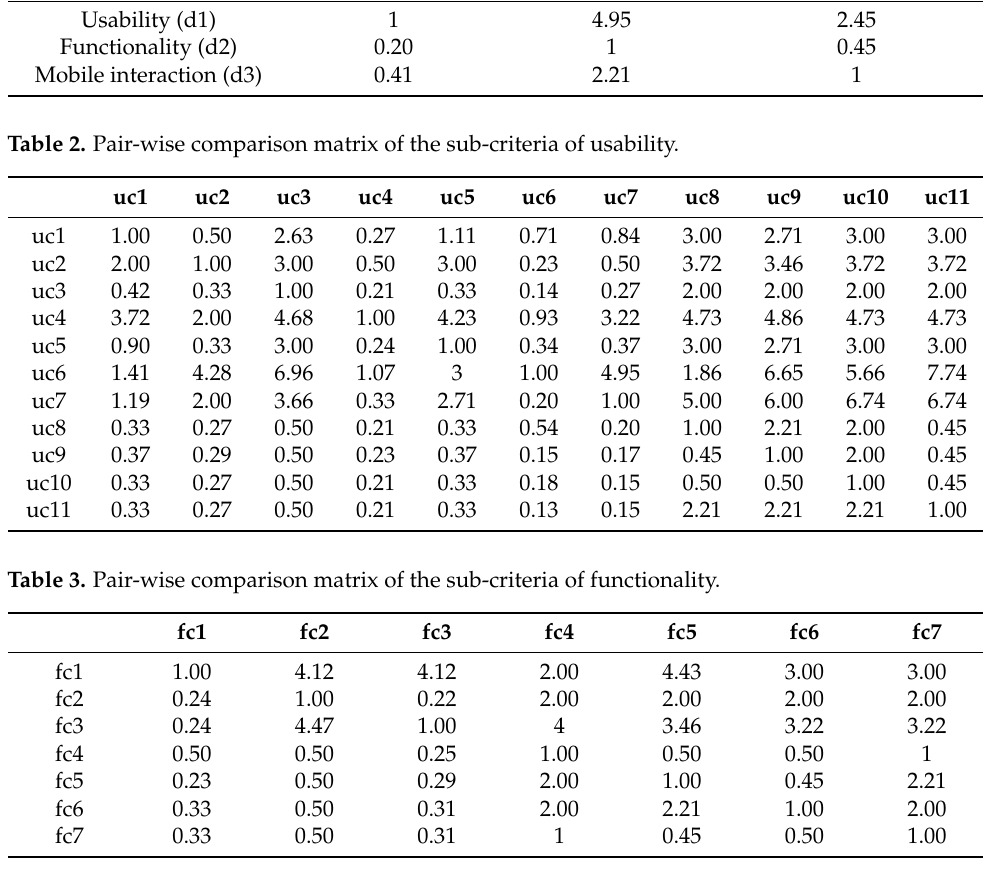
Table 4. Pair-wise comparison matrix of the sub-criteria of mobile interaction. mc1 mc2 mc3